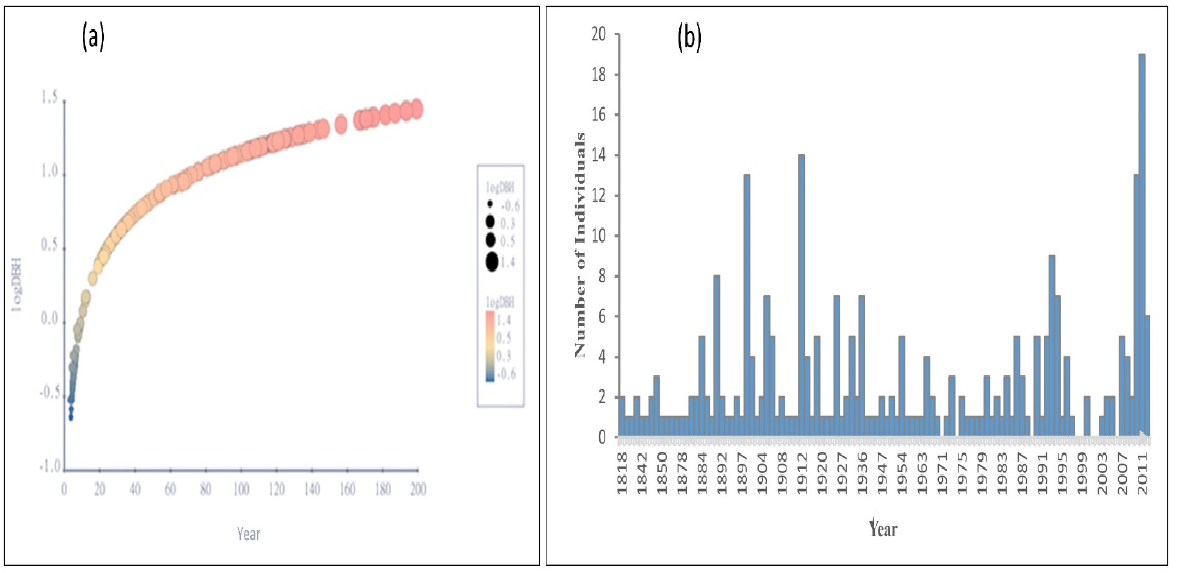
Forests 2022 , 13 , x FOR PEER REVIEW 11 of 16 Figure 8. ( a ) Age—logDBH curve of Juniperus macropoda in Lahaul Valley of Himachal Pradesh and ( b ) age-frequency of trees of Juniperus macropoda in Lahaul Valley of Himachal Pradesh.